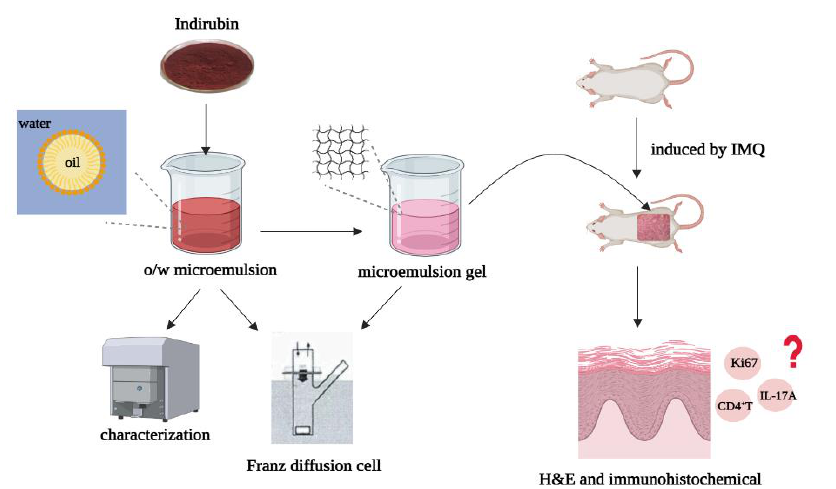
Figure 1. The schematic illustration of the study on indirubin microemulsion gel. Firstly, indirubin microemulsion was prepared and characterized, then carbomer 934 was used as a gel matrix to increase the viscosity of the microemulsion, and the anti-psoriatic activity of the preparation was evaluated by H&E and immunohistochemical